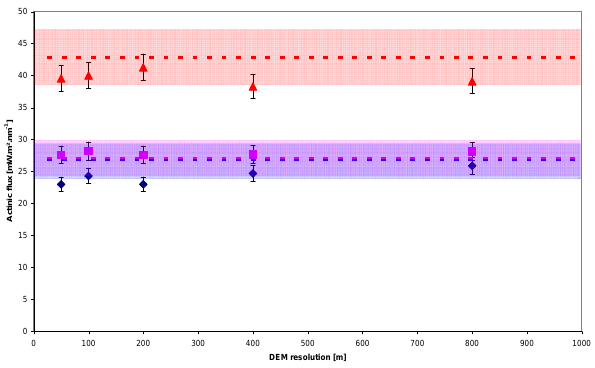
Figure 15: Modeled 3-D UV Actinic (305 nm) calculations for 24 th February, 08:20 UTC as a function of DEM resolution. Dotted lines show the measurements (interpolation of measurements before and after 08:20 UTC) which correspond to the locations and the time of calculation. Solar zenith angle is 70.0 degree. The shapes show the model results (diamond = Innsbruck, square = Lans, triangle = Hafelekar). The error bars show the accuracy of the model simulations (±5%). The coloured areas around the lines of measurements indicate the measurement uncertainty (=±10%).